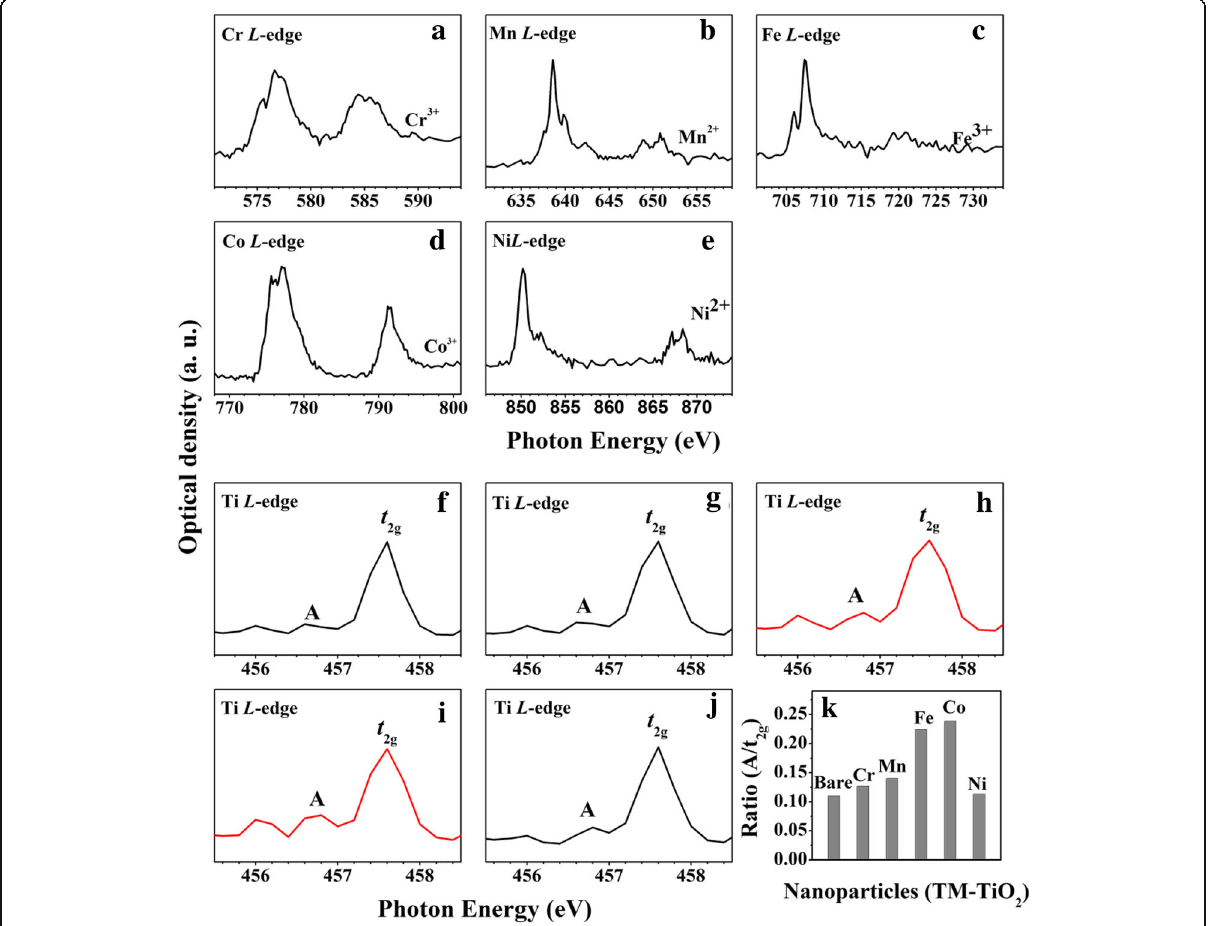
Fig. 3 The doped transition metal L -edge and Ti L -edge XAS spectra of 5 mol% TM-TiO 2 : a and f Cr-TiO 2 , b and g Mn-TiO 2 , c and h Fe-TiO 2 , d and i Co-TiO 2 , and e and j Ni-TiO 2 . k The plot of ratio between pre-edge peak a and t 2g peak for bare TiO 2 and the five TM-TiO